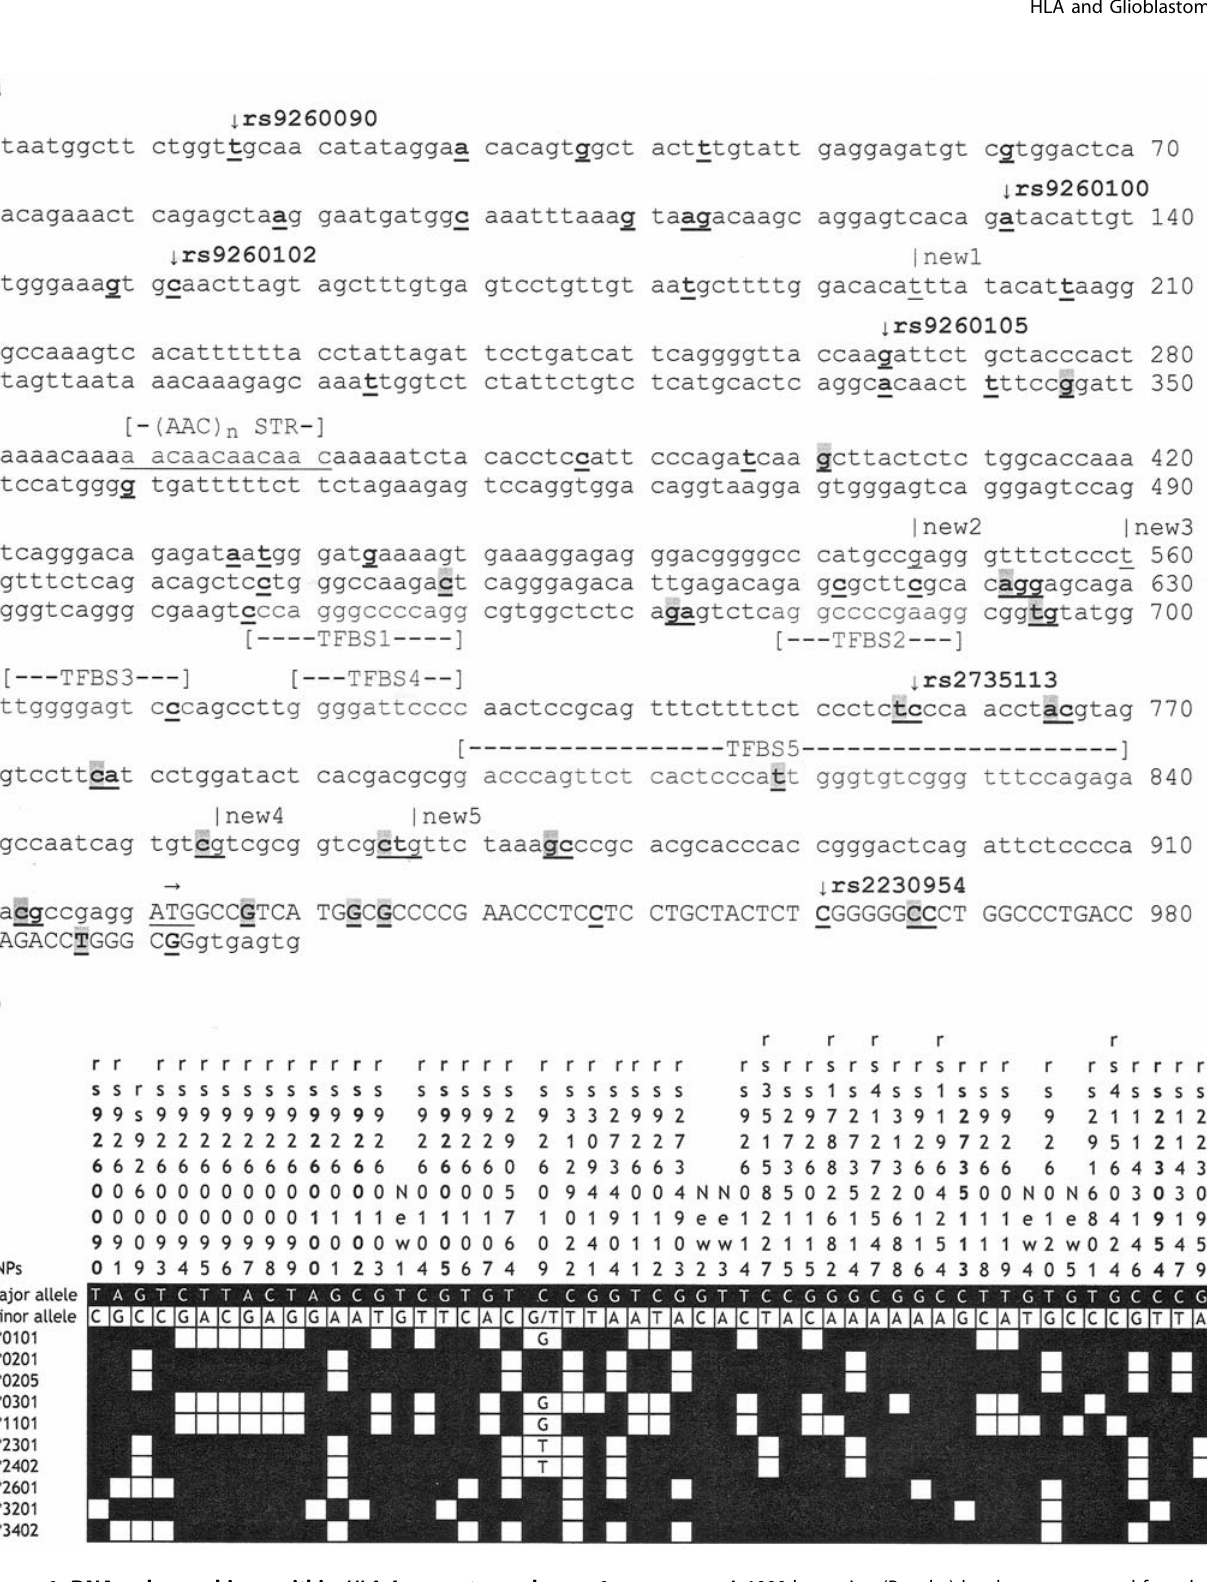
PLoS ONE | www.plosone.org